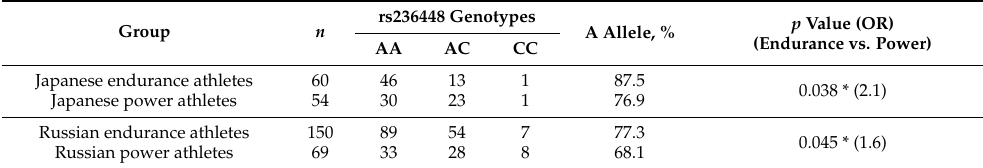
Table 1. The rs236448 SNP genotypes distribution and allelic frequencies in Japanese and Russian cohorts of athletes. Group